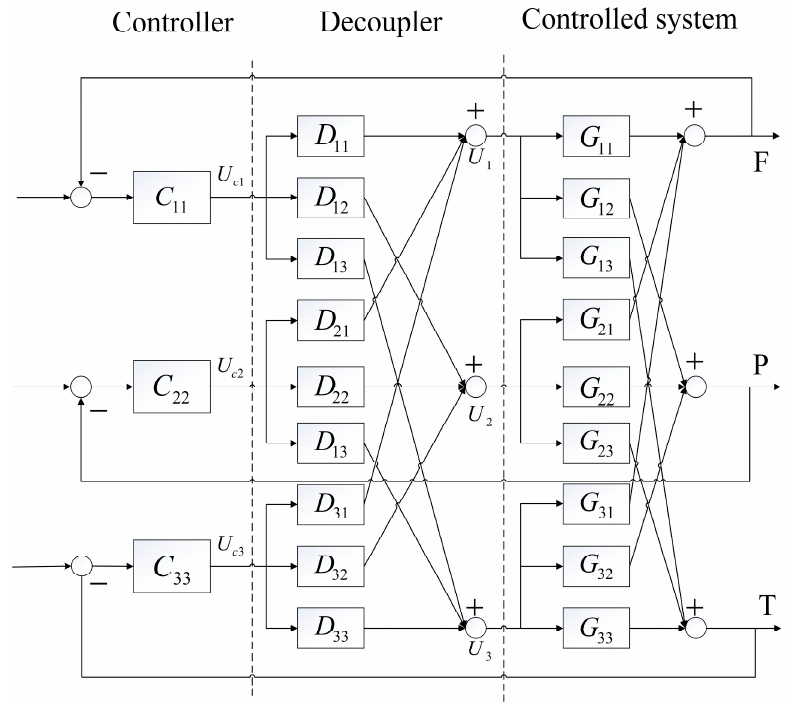
Figure 3. Block diagram of gas turbine cooling system.